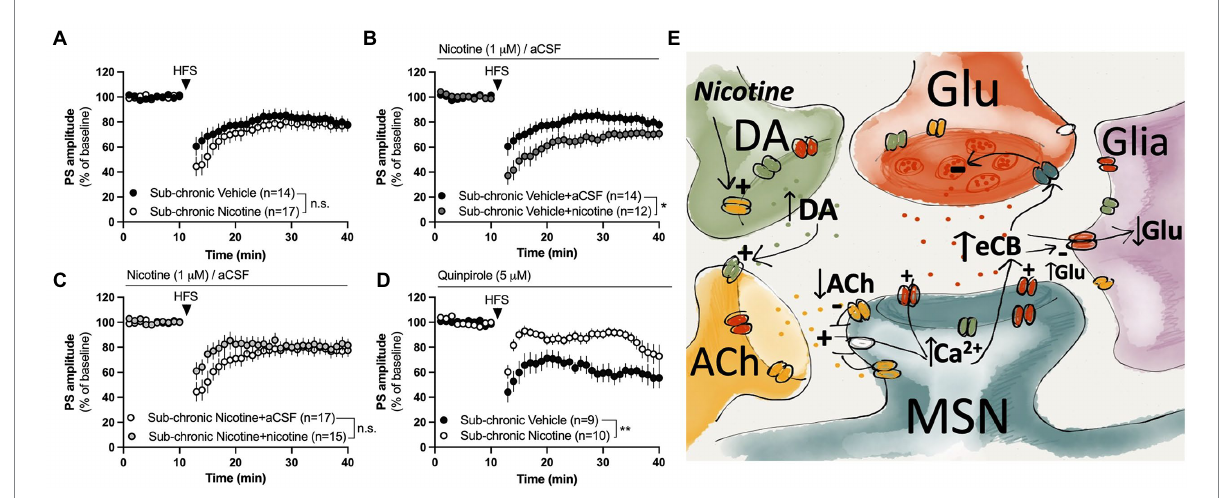
FIGURE 5 Nicotine or dopamine D2 receptor activation does not facilitate LTD in slices from female rats receiving sub-chronic nicotine treatment. (A) HFS- LTD was not significantly modulated during acute withdrawal (2–7 days) after the last nicotine exposure. (B,C) Bath perfusion of nicotine facilitated HFS-LTD in slices from vehicle-treated rats but not from nicotine-treated rats. (D) The dopamine D2 receptor agonist quinpirole selectively facilitated HFS-LTD in slices from vehicle-treated rats. (E) Simplified schematic drawing depicting putative signaling pathways that nicotine may recruit to modulate neurotransmission and HFS-LTD in the DLS. Acute administration of nicotine may weakly stimulate eCB production and release by activating nAChRs located on dopaminergic terminals, thereby increasing the inhibitory tone by dopamine on cholinergic neurons. Reduced cholinergic tone relieves the inhibition of L-type calcium channels (Wang et al., 2006), thereby facilitating calcium influx and eCB production in MSNs. When nicotine is combined with HFS, eCB signaling is potentiated compared to HFS alone, thereby leading to a more robust depression of PS amplitude. Following sub-chronic nicotine exposure, however, the regulatory role of dopamine D2 receptors appears to be altered. Endocannabinoids may also reduce glutamate uptake (Brown et al., 2003), thereby increasing extrasynaptic glutamate levels and further promoting eCB signaling and synaptic depression. Data are mean values ± SEM. n = number of slices, taken from at least three animals. * p < 0.05, ** p <